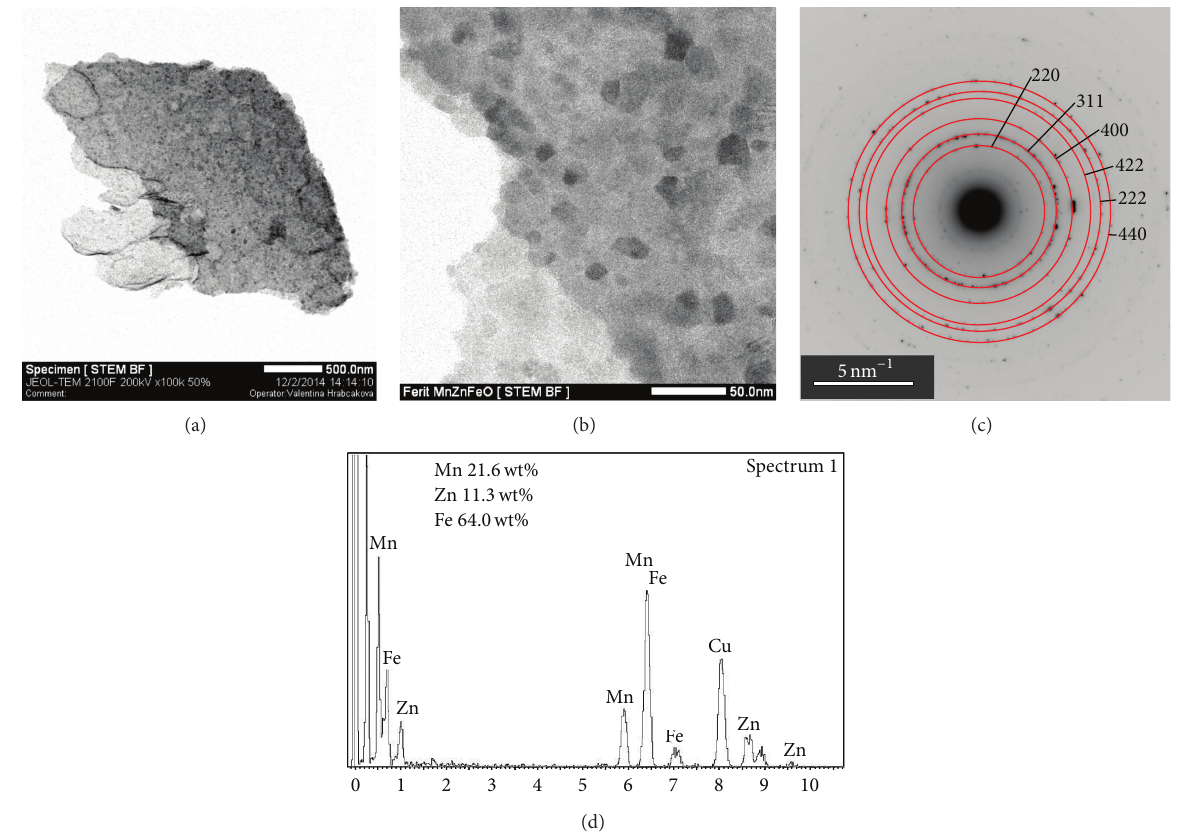
Figure 5: (a) TEM image of Mn 0.8 Zn 0.2 Fe 2 O 4 powder, (b) zoom of Mn 0.8 Zn 0.2 Fe 2 O 4 powder, (c) diffractogram, and (d) EDX analysis.